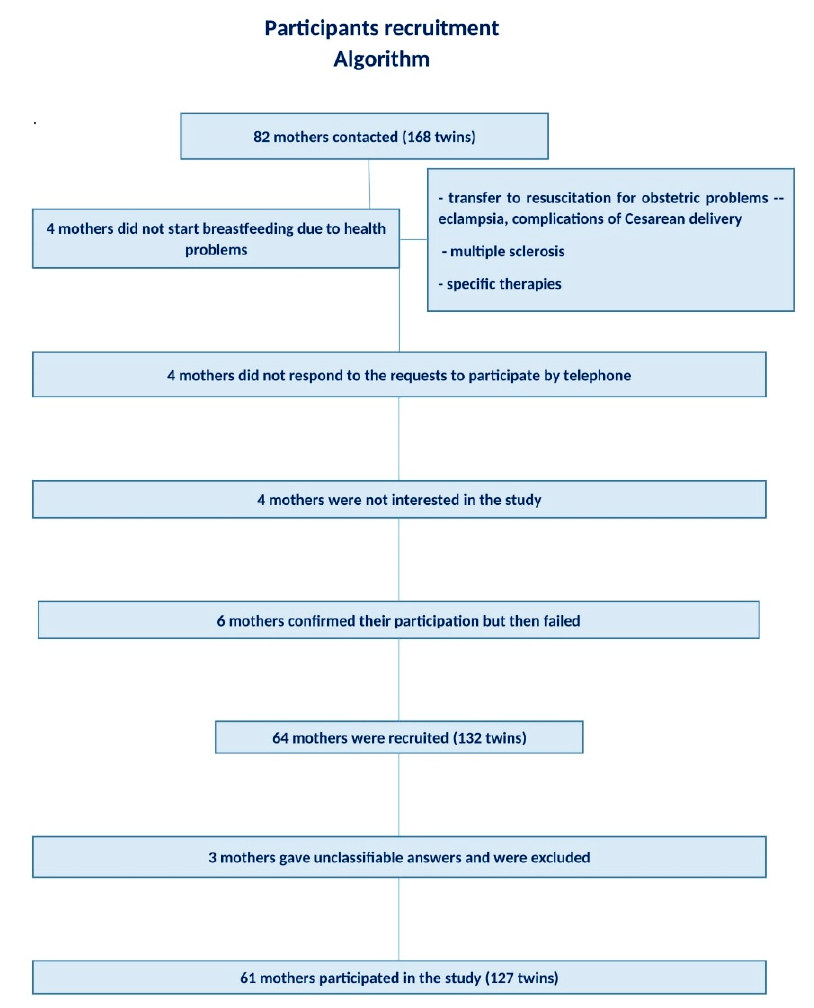
Figure 1. Algorithm partecipants recruitment.